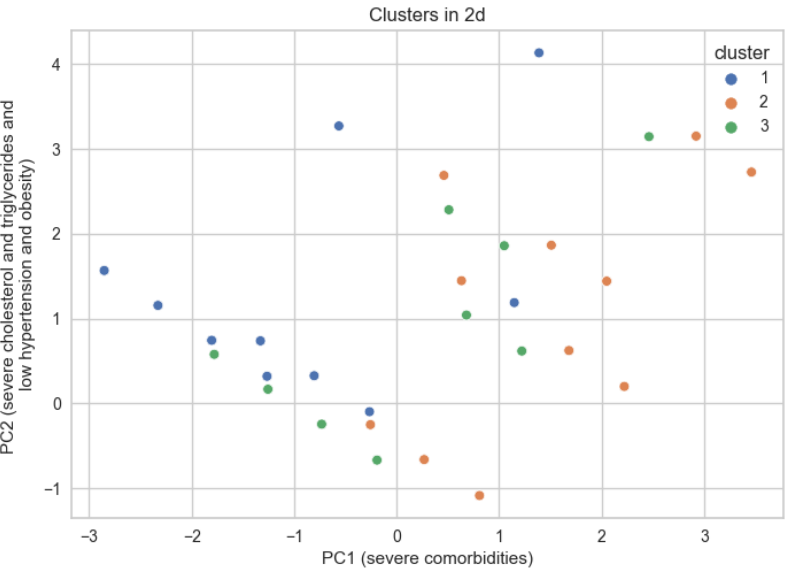
Figure 7. Observations grouped by cluster in 2d space.